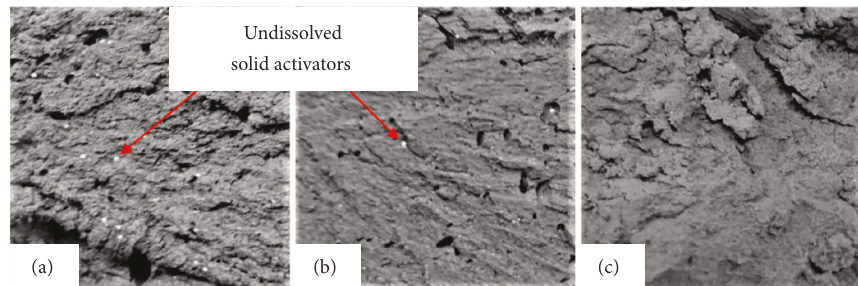
Figure 19: Flocculation process generated by base reaction in concrete materials [39].